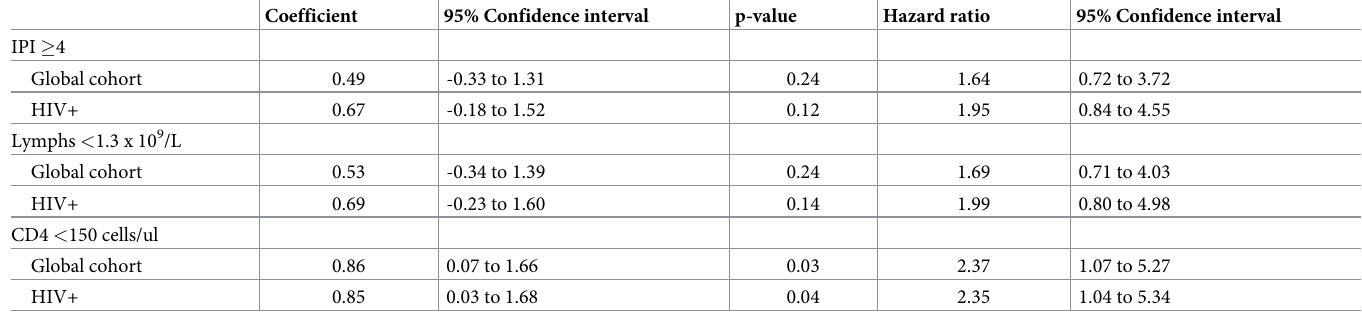
Table 7. Cox proportional-hazards regression analysis for independent associations between the survival time and the IPI, CD4 count and a lymphocyte count < 1.3 x 10 9 /L.